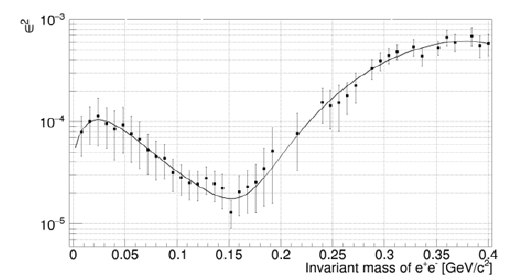
Figure 5. The distribution of the invariant mass of e + e − for selected data and Monte Carlo simulations of signal and background channels. Black points are experimental data.